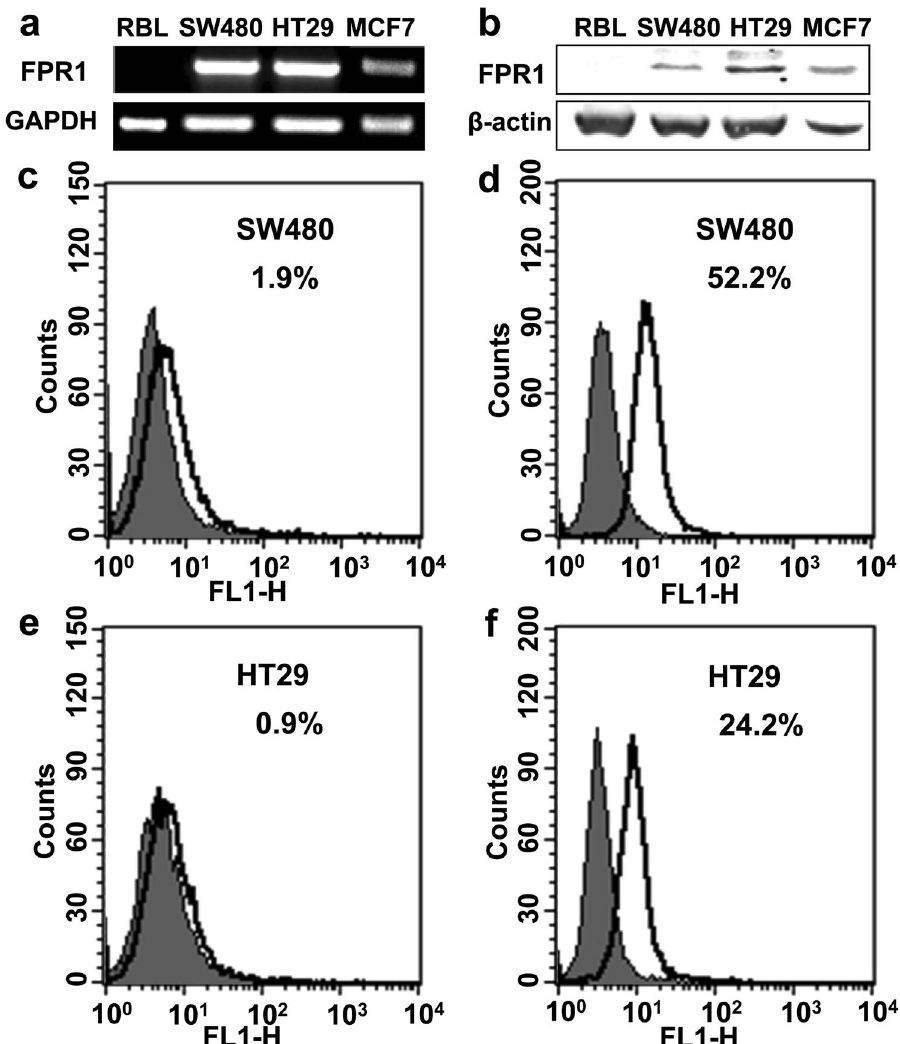
Figure 3. Expression of FPR1 in colorectal cancer cell lines. The mRNA transcripts ( a ) and protein expression ( b ) of FPR1 in SW480 and HT29 were analyzed by agarose gel electrophoresis and western blotting, respectively. The full-length gels and blots were presented in Supplementary Fig. S4a and b. ( c – f ) Flow cytometry was used to confirm the distribution of FPR1 expression in these two cell lines. The cells were treated with or without membrane-penetration solution to detect the total protein expression ( d , f ) and membrane expression ( c , e